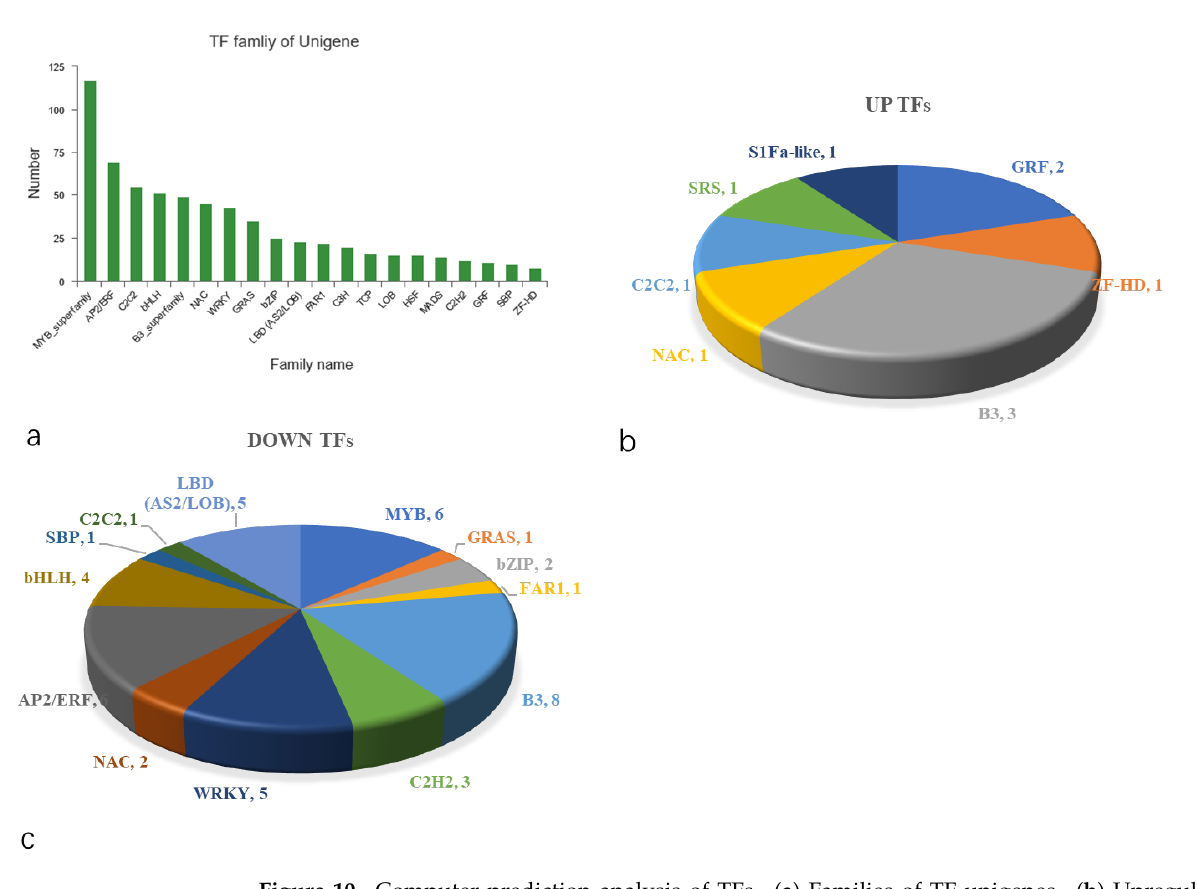
Figure 10. Computer prediction analysis of TFs. ( a ) Families of TF unigenes. ( b ) Upregulated differentially expressed TF genes. ( c ) Downregulated differentially expressed TF genes.